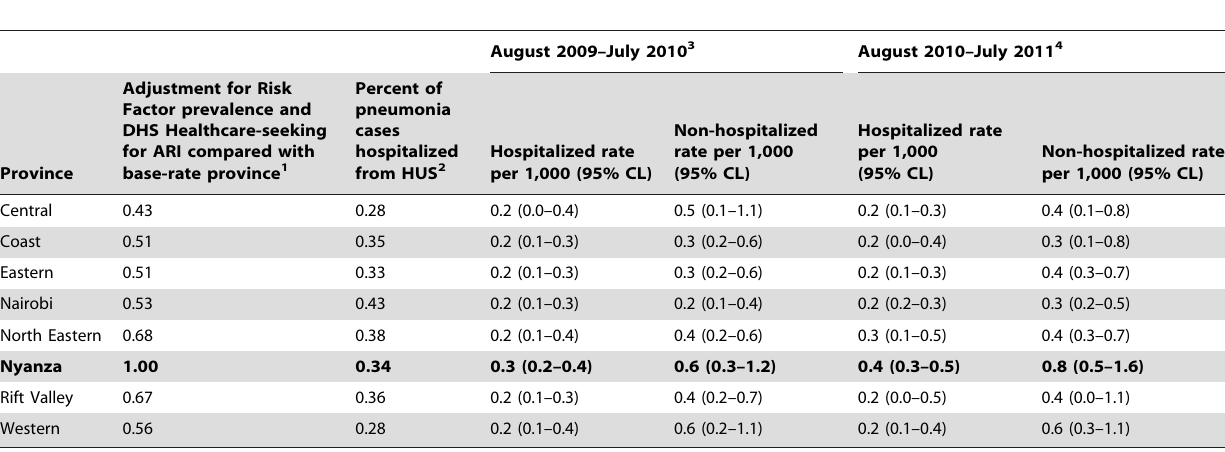
Table 3. Rate (per 1,000) and 95% confidence limits of influenza-associated severe acute respiratory illness (SARI) among